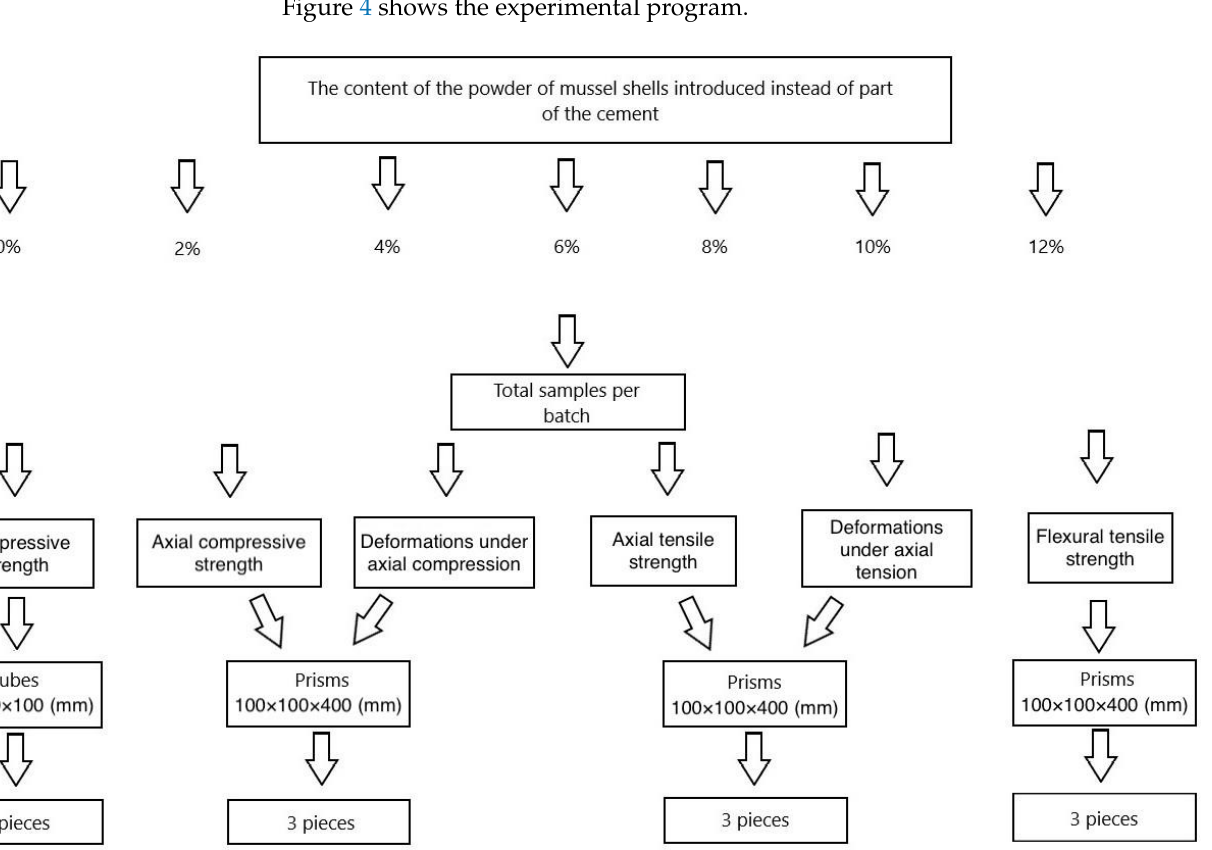
Figure 4. Experimental program.